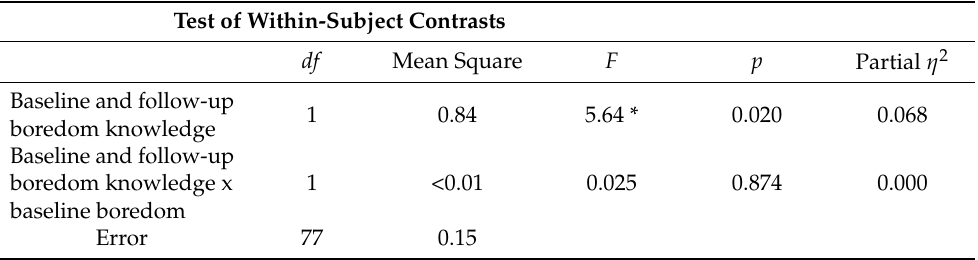
Table 2. Analysis of Phase I boredom knowledge.